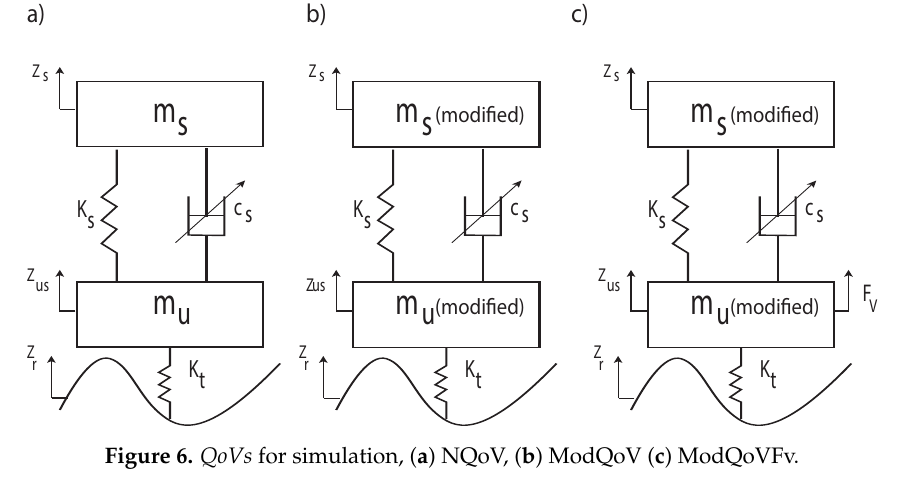
Figure 6. QoVs for simulation, ( a ) NQoV, ( b ) ModQoV ( c )